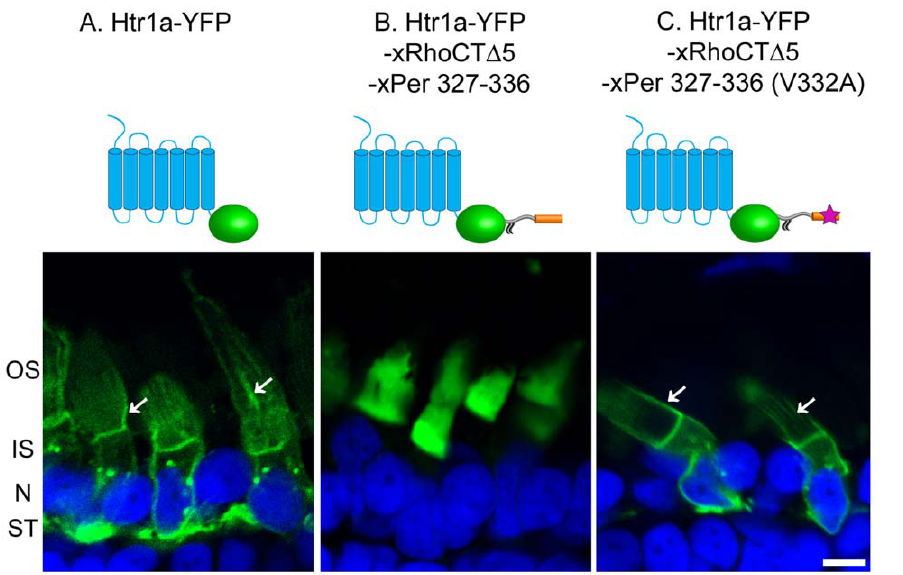
Figure 3. The peripherin targeting sequence redirects the subcellular targeting of the Htr1a serotonin receptor. Panels show confocal images of transgenic frog retinas expressing YFP-fused Htr1a constructs (green) schematically illustrated above each panel. (A) Htr1a-YFP; fluorescent signal observed in calycal processes is marked by white arrows. (B) Htr1a-YFP containing the Per327–336 sequence fused at the C-terminus. (C) Same construct as in (B), but bearing the V332A mutation. Abbreviations are: OS – outer segment, IS – inner segment, N – nuclei, ST – synaptic termini. Nuclei (blue) are stained with Hoechst. Scale bar: 5 m m.